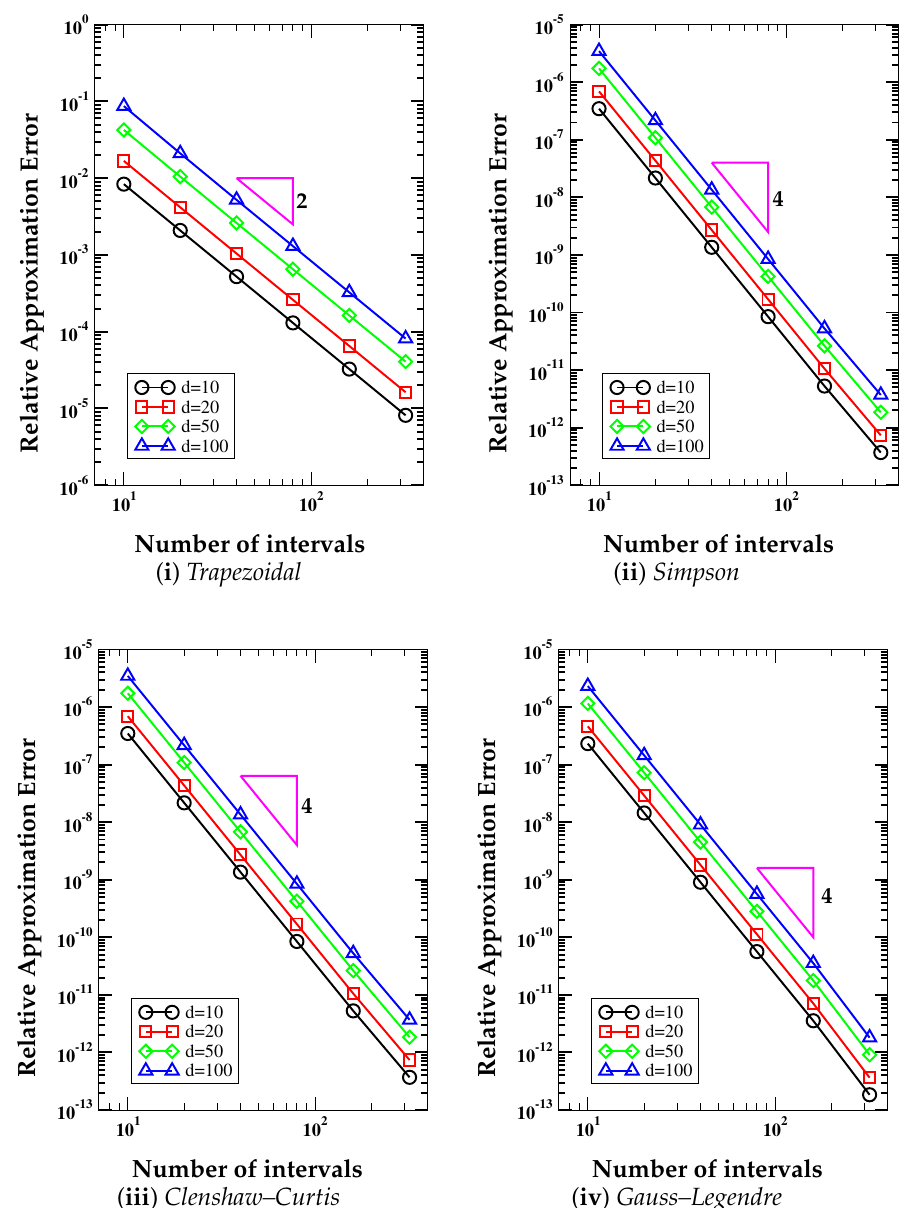
Figure 4. Test Case 3. Relative approximation error curves versus the number of intervals N per direction for the numerical integration of a d -dimensional exponential function (Genz-5), d = 10,20,50,100, using the ( i ) trapezoidal formula ( m = 2); ( ii ) Simpson formula ( m = 4); ( iii ) Clenshaw–Curtis formula ( m = 4); ( iv ) Gauss–Legendre formulas ( m = 2 ) . The expected convergence rate is shown by the number close to the triangular shapes and is proportional to N − 2 (trapezoidal rule) and N − 4 (Simpson, Clenshaw–Curtis, and Gauss–Legendre